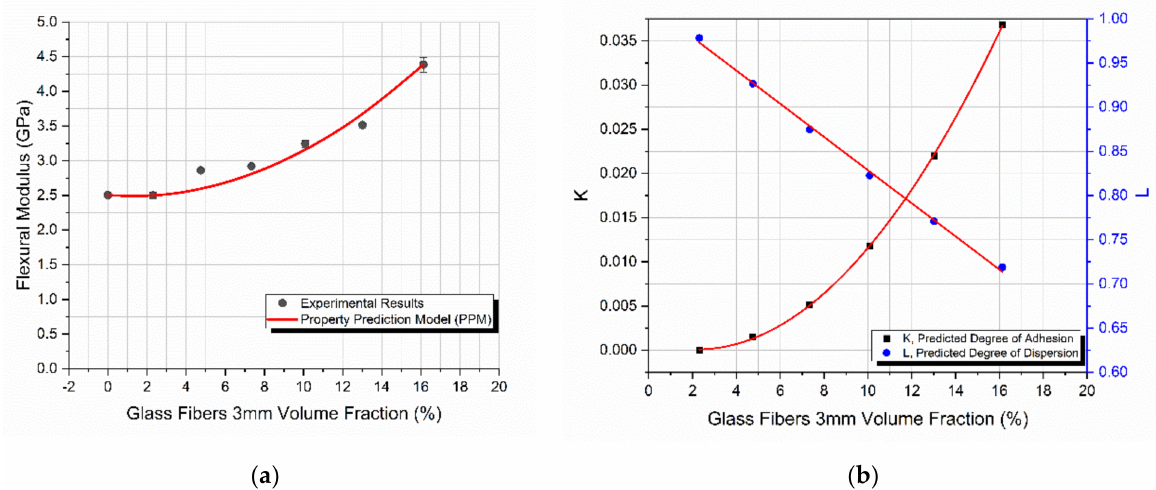
Figure 4. The starch-epoxy composites variation of 3 mm glass fibers with the filler-volume fraction V f , of ( a ) flexural modulus experimental and predicted values, ( b ) degree of adhesion K , and degree of dispersion L predicted